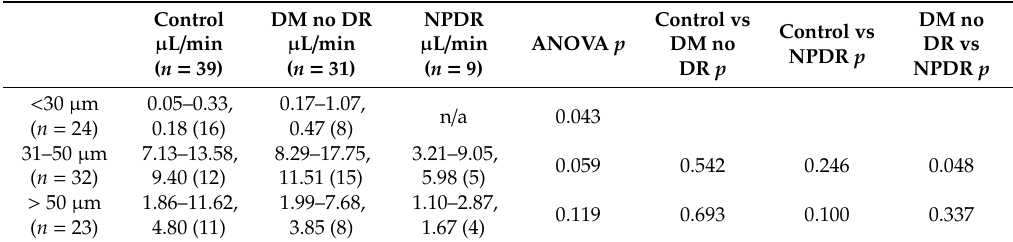
Table 7. Summary of venular blood flow by vessel diameter groups, comparing healthy controls, diabetes without retinopathy, and non-proliferative diabetic retinopathy.